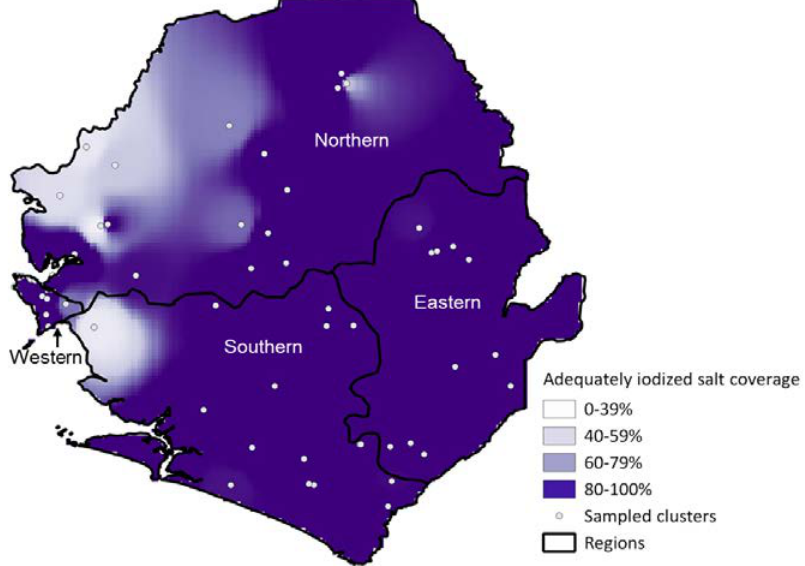
Figure 1. Geographic distribution of coverage of adequately iodized salt (≥15 mg/kg), Sierra Leone, 2013.